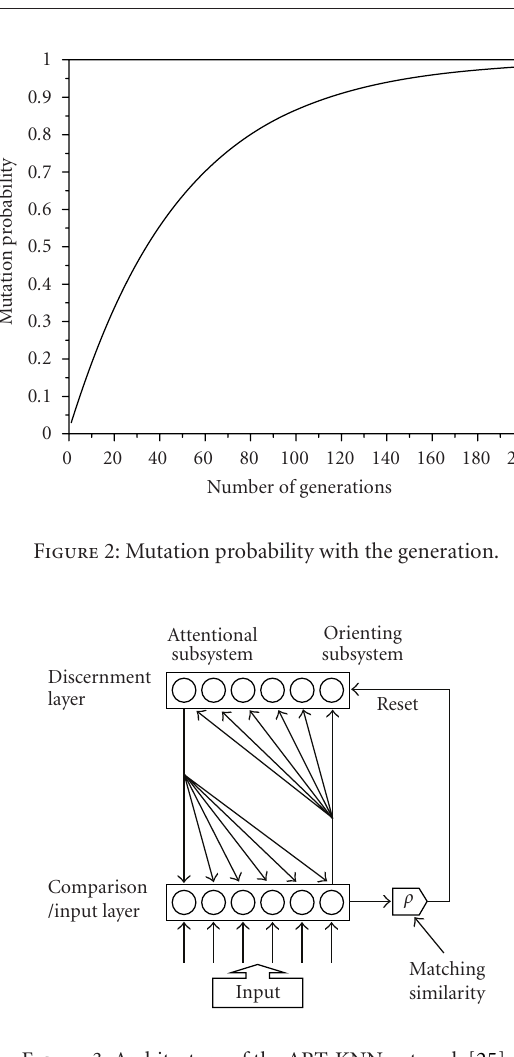
Figure 3: Architecture of the ART-KNN network